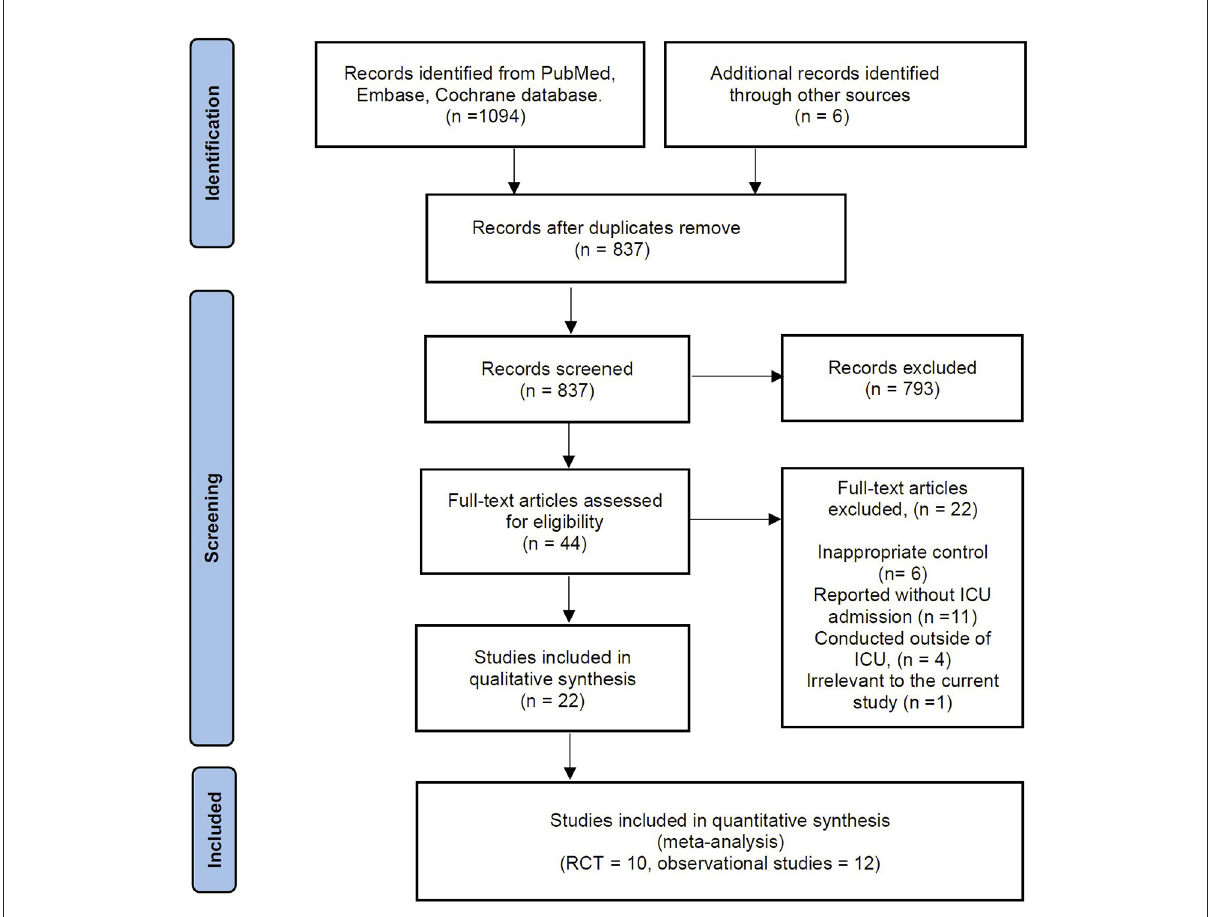
FIGURE1 Selection process for the studies included in the